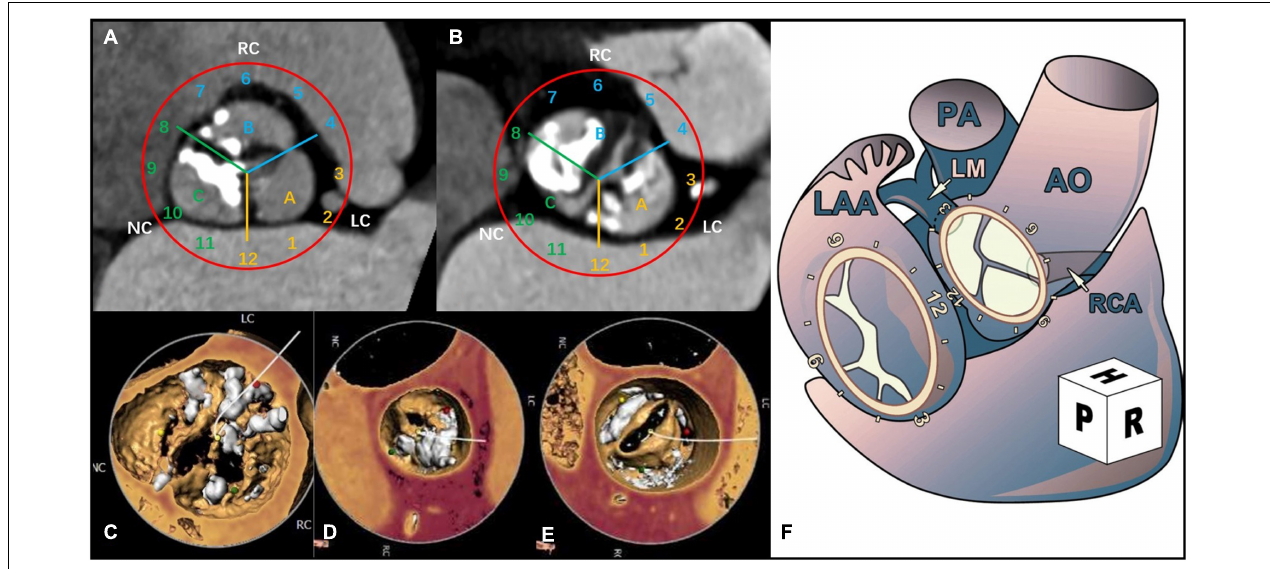
FIGURE 1 | Computerized tomography angiography (CTA) shows the distribution of aortic valve calcification using a surgeon’s view clock-face model. (A) The CTA cross section shows the distribution of the tricuspid aortic valve (TAV) calcification. (B) The CTA cross section shows the distribution of the bicuspid aortic valve (BAV) calcification. (C) 3-Dimensional (3D) view of the CTA image shows the eccentric calcification of the aortic valve in region A. (D) 3D view of the CTA image shows eccentric calcification in region B. (E) 3D view of the CTA image shows eccentric calcification in region C. (F) Surgical view of the left atrium (Ruiz et al.,